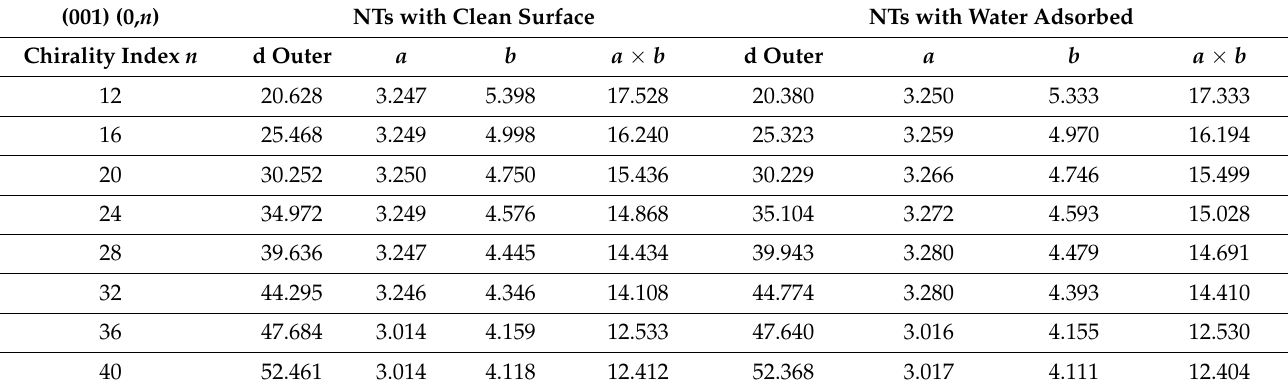
Table 4. Parameters of 6-layered (001) (0, n ) TiO 2 NTs, simulated with and without water. The lattice parameter correspond- ing to the NT axis is denoted with a , d stands for outer diameter, b —for outer b constant along NT circumference, and a × b —their product. (001) (0, n